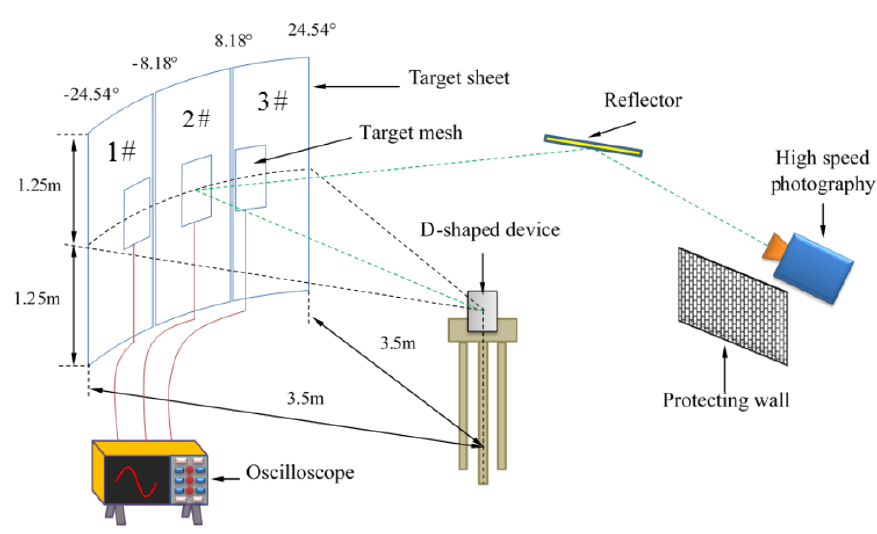
Figure 4. Schematic diagram of experimental